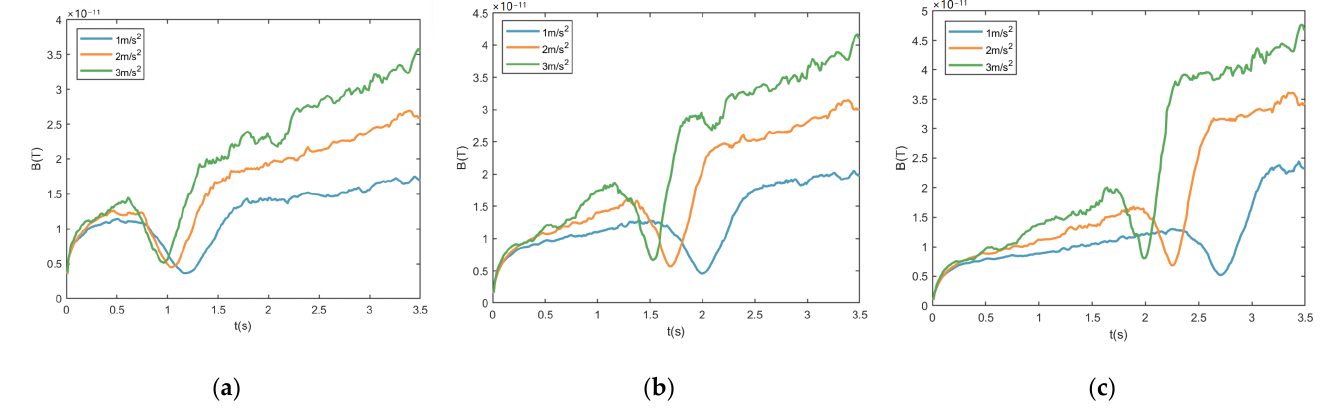
Figure 15. The time domain contrast diagram of the magnetic field at the same monitoring point when the submarine moved with different accelerations. Monitoring points ( a ) B, ( b ) C, and ( c ) D.